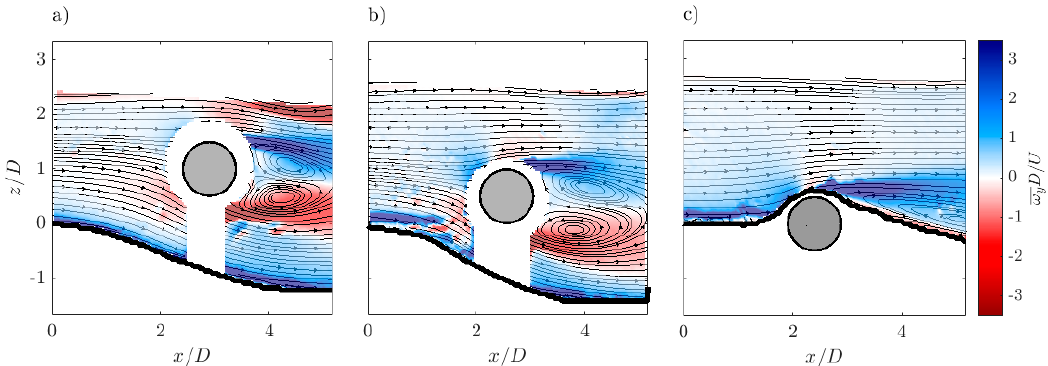
Figure 8. Dimensionless ensemble-averaged vorticity fields on a vertical plane in ( a ) Run 1, ( b ) Run 2 and ( c ) Run 3.